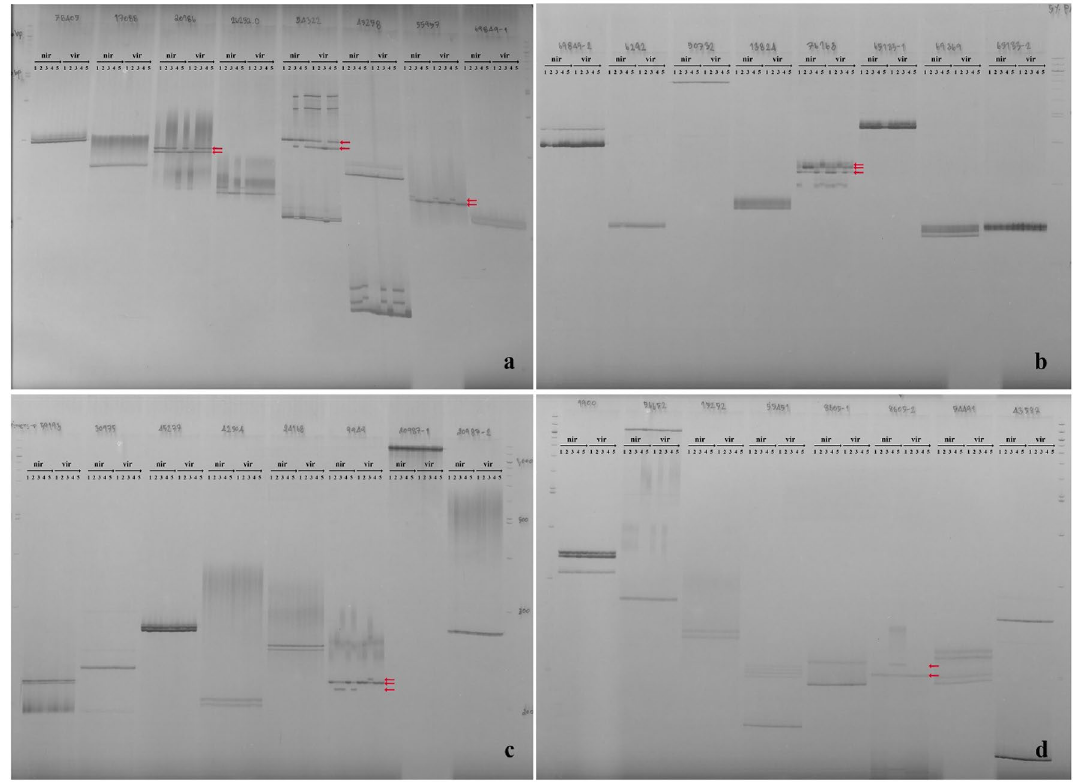
Figure 6. Polymorphisms of DNA bands after amplification with 6 primer pairs and separation by 5% denaturing polyacrylamide gel electrophoresis. ( a ) Primer 20,186, 54,322 and 55,957, ( b ) Primer 76,163, ( c ) Primer 9949, (d) Primer 8605–2. nir = nigrescent type of Nigeria Black, vir = virescent type of Deli × Calabar. 1–5 = replication in each morphotype. The red arrows indicate the different